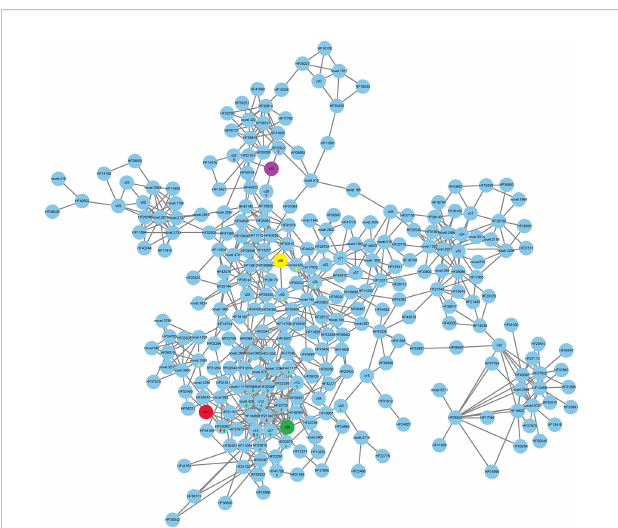
FIGURE 5 Correlation network for volatiles and DEGs. A correlation subnetwork was constructed using the data for DEGs shared by pairs of samples in the Venn diagrams and the content of the fl oral volatiles. The 4 fragrant volatiles, comprising linalool (leaf acetate, v01, color red), methyl benzoate (v06, color yellow), leaf acetate (v10, color purple), and methyl anthranilate (v26, color green), were used as guide data and are labeled with different colors. A correlation between v01, v06, v10, v26 and DEGs or other volatiles was labeled by a diamond with the corresponding